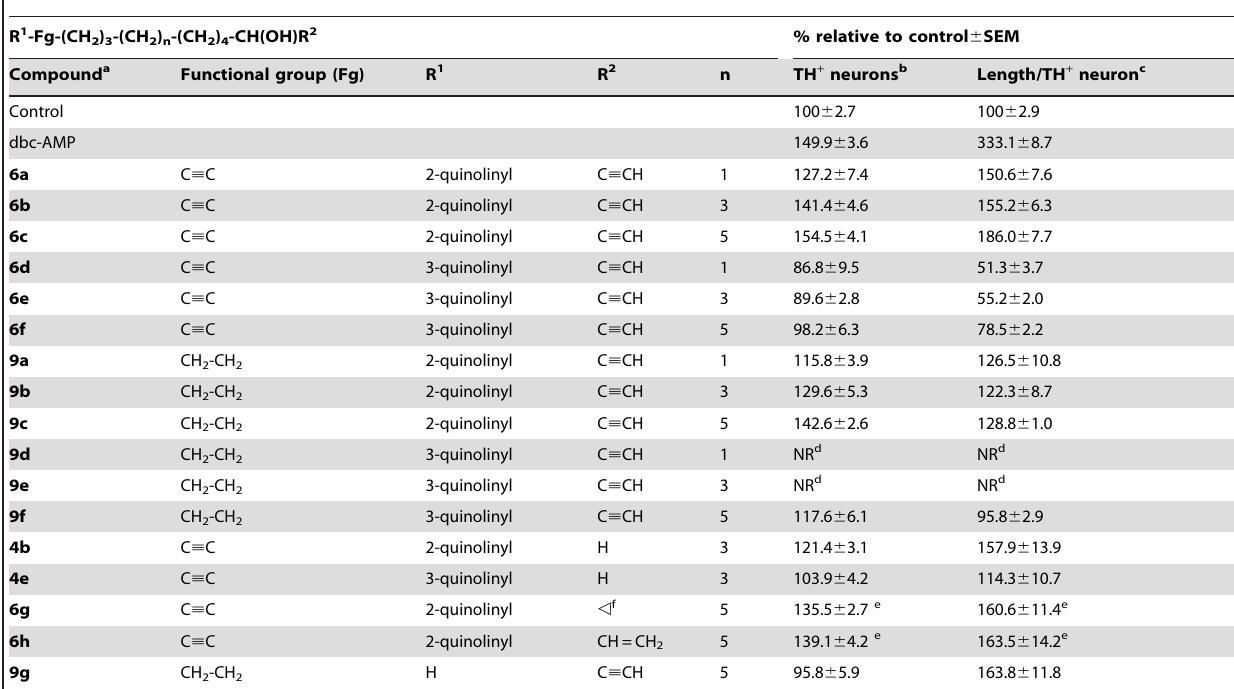
Table 1. Neuroprotective and neuritogenic activities of LBA-derived compounds on mesencephalic DA neurons.